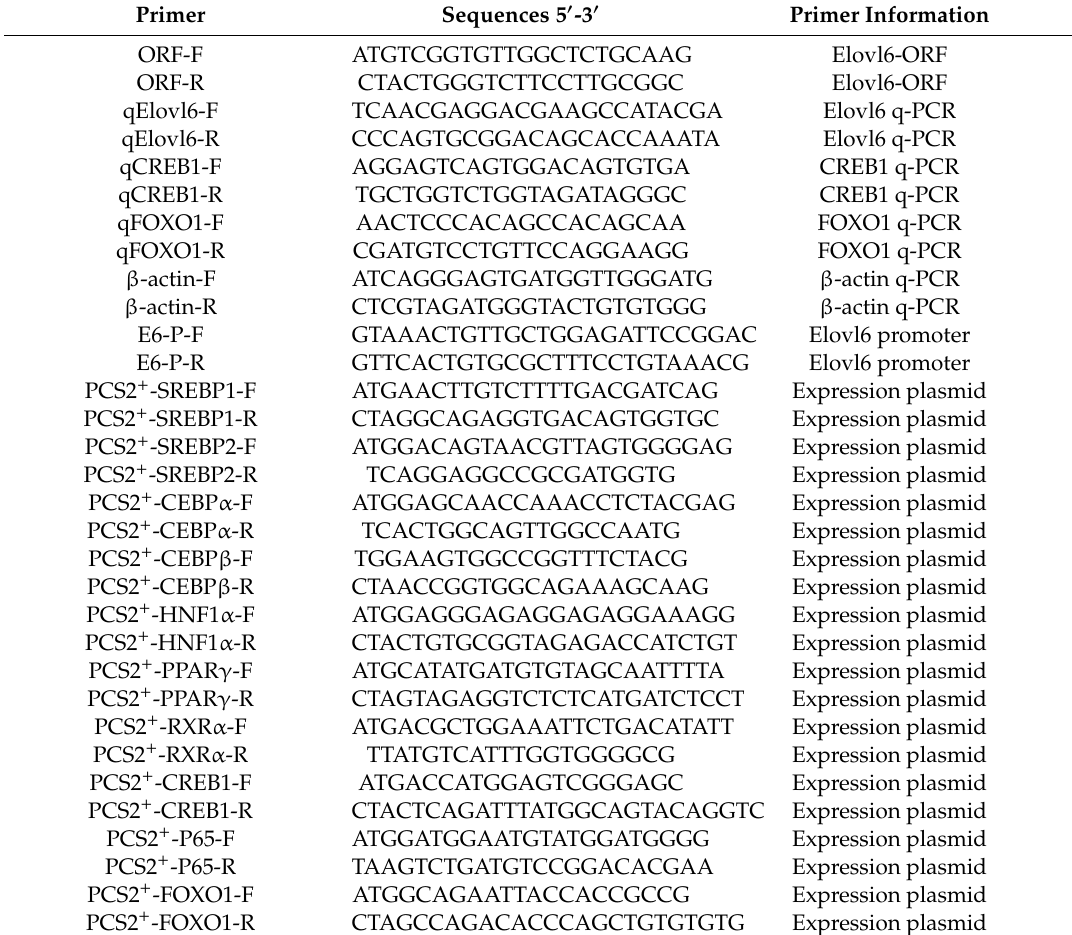
Table 1. Sequences of the primers for gene cloning, qPCR analysis, and promoter cloning. Primer Sequences 5 (cid:48) -3 (cid:48) Primer